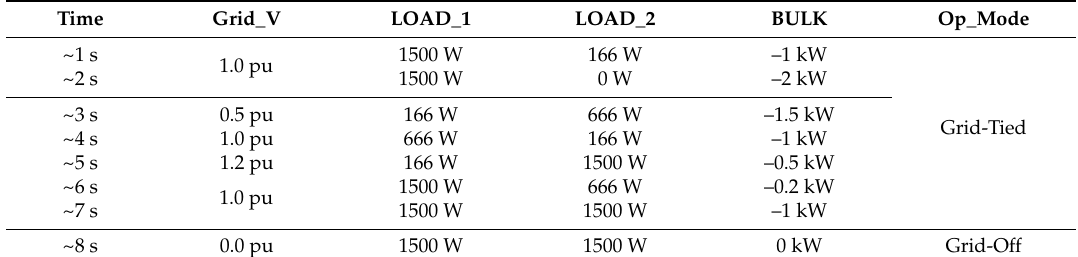
Table 3. Simulation scenario for operational